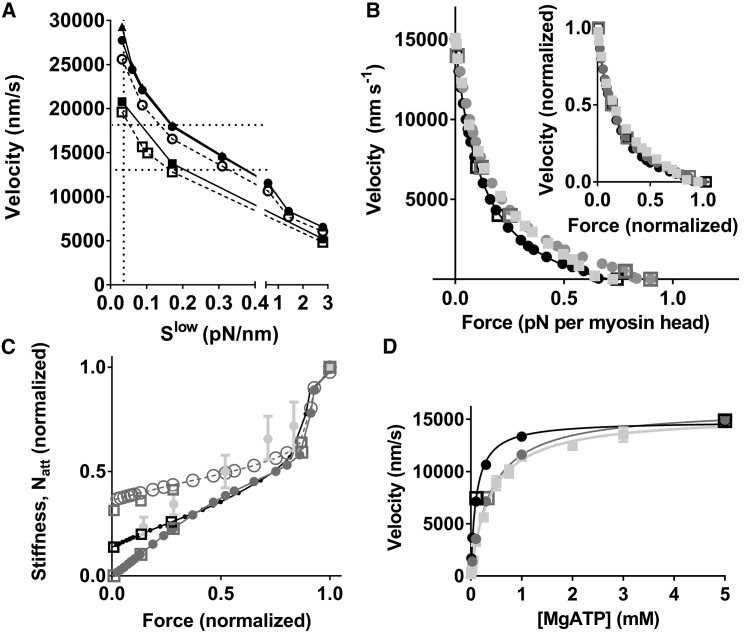
Model predictions for steady-state contractile properties on the assumption of linear or non-linear cross-bridge elasticity. (A) Velocity as function of the cross-bridge stiffness (Slow) in the AM/AMD state in the range −75 nm < x < −4 nm. Rate function k2(x) is strain independent (xcrit = 0). Full lines and filled symbols: k2(x) = k2(0) = 1800 s−1. Dashed lines and open symbols: k2(x) = k2(0) = 1600 s−1. Circles: cross-bridge stiffness linear in AMDL and AMDH states. Filled triangles: stiffness linear in AMDL state but nonlinear in AMDH state ((10a), (10b), a and b). Filled squares: stiffness linear in AMDH state but nonlinear in AMDL state ((9a), (9b), a and b). Open squares: nonlinear cross-bridge elasticity in all states. Vertical dotted line: the degree of nonlinearity (Slow = 0.03 pN/nm) observed in AM/AMD state in (29). Horizontal dotted lines: experimental range of velocities (see text for references). (B) The force-velocity relationship. The experimental data (light gray) are from mouse intact muscle at 30°C (62). Black filled circles: simulations assuming linear elasticity and standard parameter values (Tables S1 and S2) without periodic boundary conditions. Black open squares: similar simulations but with periodic boundary conditions. Dark gray filled circles: simulations assuming nonlinear elasticity and standard parameter values (Tables S1 and S2) without periodic boundary conditions. Dark gray open squares: same as previous but with periodic boundary conditions. Isometric force for experimental data is scaled to data represented by filled black circles. Inset: data normalized to maximal velocity and maximal force for each data set. Note excellent reproduction of experimental data, including nonhyperbolic shape at high loads, by all versions of the model. Maximal isometric force corresponds to ∼120–130 kPa on the whole-fiber level. (C) Stiffness attributed to linear cross-bridge elasticity in experimental data (10) (light gray), corrected for linear myofilament elasticity estimated in the same experiments. Note that the experiments (mean ± standard error of the mean) are from frog fast muscle fibers at 4°C. The grayscale coding of symbols and lines is the same as in (B) but with the addition of open circles representing normalized number of attached cross-bridges (Natt) for nonlinear cross-bridge elasticity in all states. Open squares represent simulations of stiffness and Natt using periodic boundary conditions. (D) Velocity versus [MgATP] for experimental data (20) and simulations assuming either linear (black) or nonlinear (dark gray) cross-bridge elasticity for all attached cross-bridge states is shown. The same grayscale coding as in (B) is used.